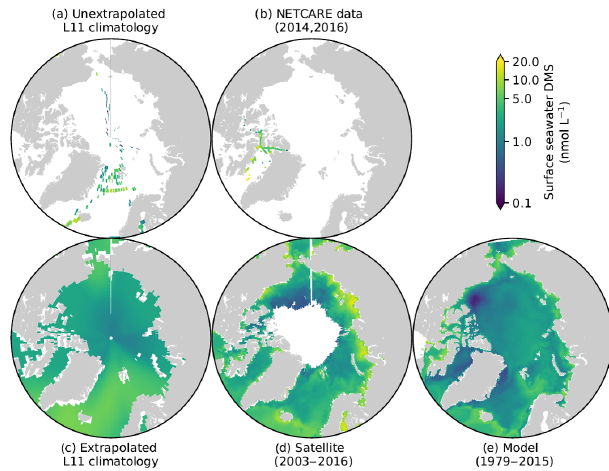
Figure 5. Pan-Arctic distribution of July–August concentrations of surface ocean DMS. Upper panels show the comparison between (a) the discrete (Lana et al., 2011) climatology and (b) the data collected during the two NETCARE field campaigns. Lower pan- els compare (c) the standard (Lana et al., 2011) climatology with (d) the satellite-derived (Galí et al., 2018; Hayashida, 2018) and (e) model-based (Hayashida, 2018) climatologies developed within